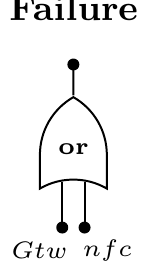
Figure 11. Events that conduct to a network